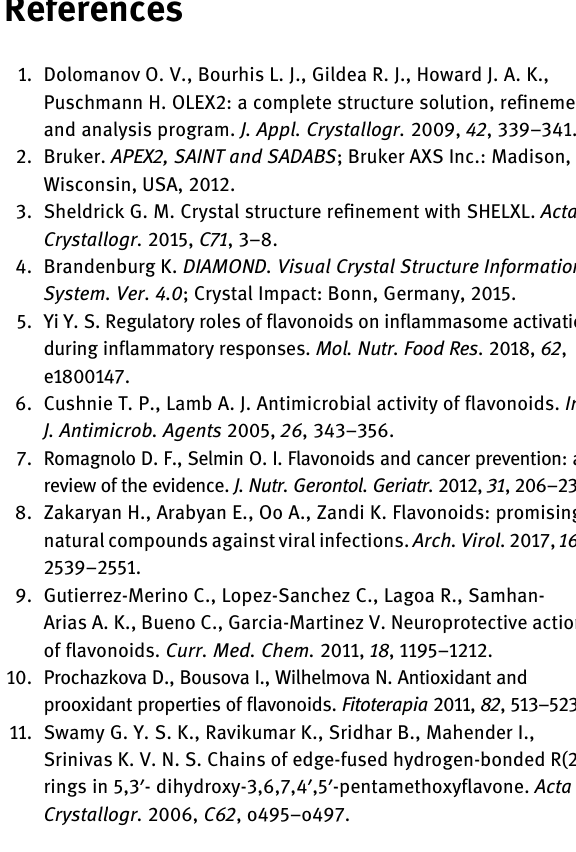
— O ); the C — O 18 7 — O ), 10 3